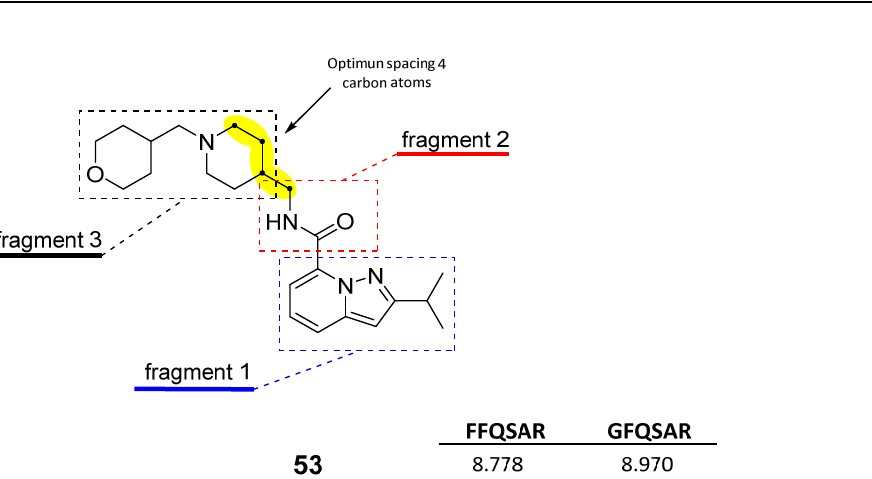
Figure 8. Template molecule ( 53 ) used for the derivation of new molecules/compounds with enhanced bioactivity.